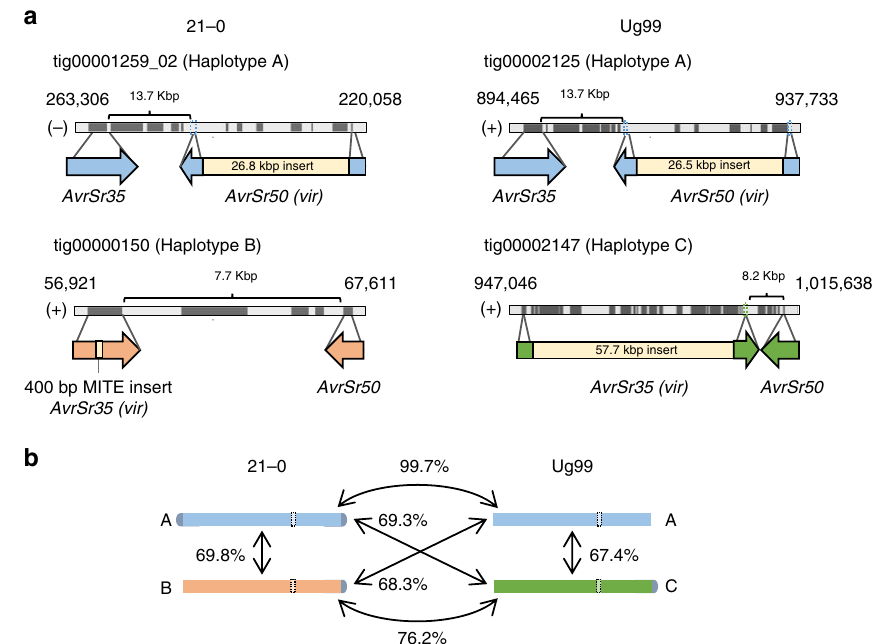
Fig. 2 A common haplotype containing AvrSr50 and AvrSr35 is shared between Pgt 21-0 and Ug99. a Diagram of genomic regions containing AvrSr50 and AvrSr35 alleles in Pgt 21-0 and Ug99. Numbers above tracks correspond to contig coordinates and the sense of the DNA strand is indicated as + or − . Predicted gene models (including introns) are depicted as dark grey boxes and intergenic spaces are shown in light grey. Coloured arrows indicate location and direction of AvrSr50 and AvrSr35 genes, with size and position of insertions shown in yellow. Intergenic distances between AvrSr50 and AvrSr35 are indicated by brackets. b Total sequence identity between contigs representing homologous chromosomes of different haplotypes (coloured bars) containing the AvrSr50 / AvrSr35 locus (dotted white boxes). Telomere sequences are represented in grey. Chromosome size = ~3.5